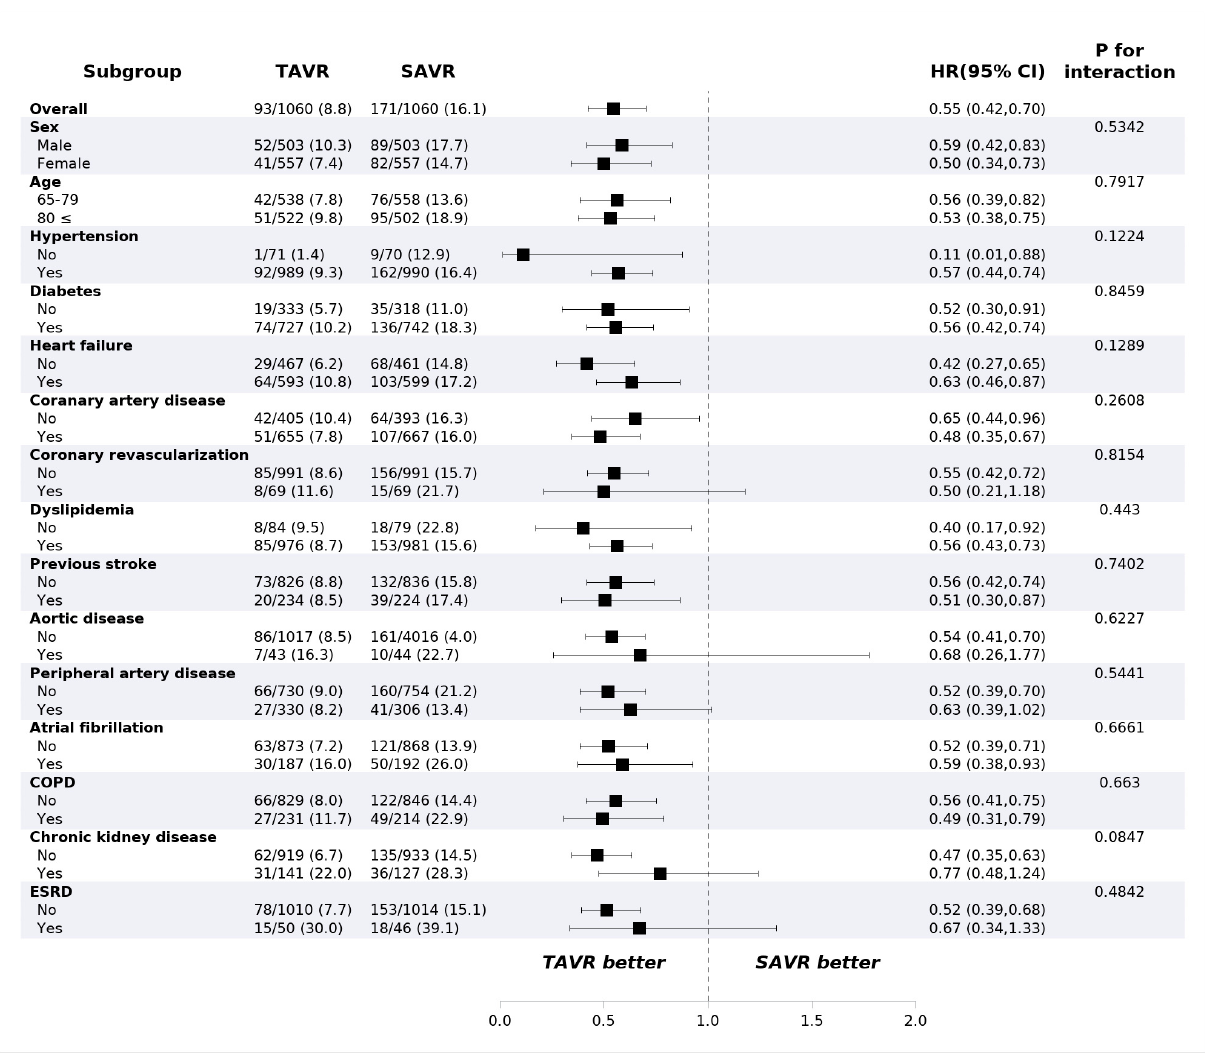
Figure 2. Kaplan–Meier curves of clinical events and safety outcomes. ( A ) all-cause death. ( B ) is- chemic stroke. ( C ) intracranial hemorrhage. ( D ) composite of all-cause death, ischemic stroke, or intracranial hemorrhage. ( E ) permanent pacemaker. ( F ) repeat procedure. SAVR, surgical aortic valve replacement; TAVR, transcatheter aortic valve replacement.